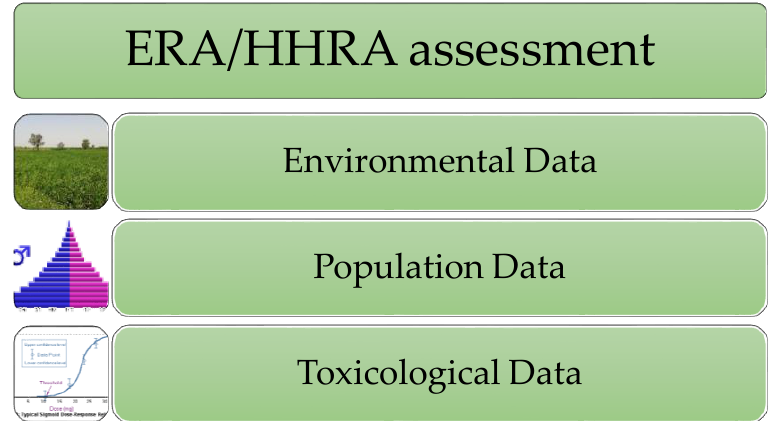
Figure 1. The scheme of the three main input datasets for risk assessment analysis.